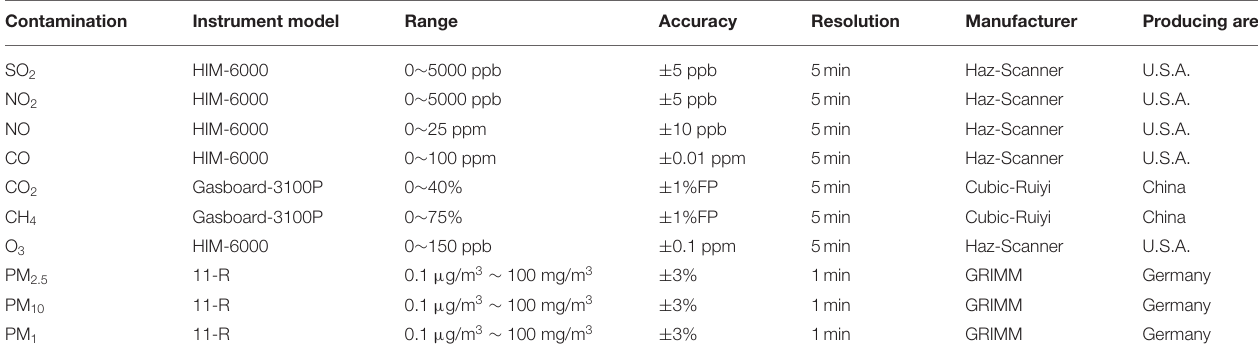
TABLE 2 | The measurement ranges and